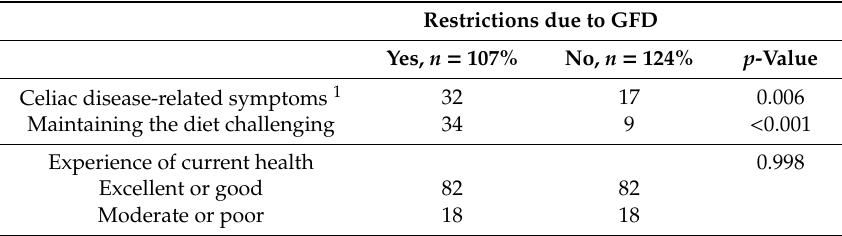
Table 3. Current experience of health and celiac disease in 231 adults diagnosed in childhood with and without self-reported restrictions caused by a gluten-free diet